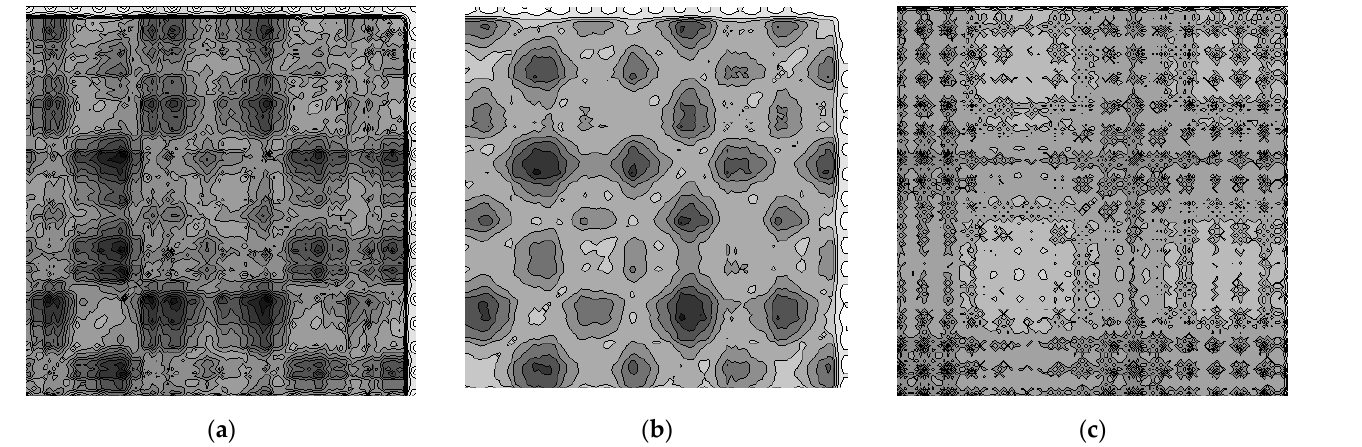
Figure 6. Recurrence plots for sound emissions of insert 1: ( a ) new tool; ( b ) worn tool flank wear of 0.3 mm; ( c ) worn tool flank wear of 0.36 mm.